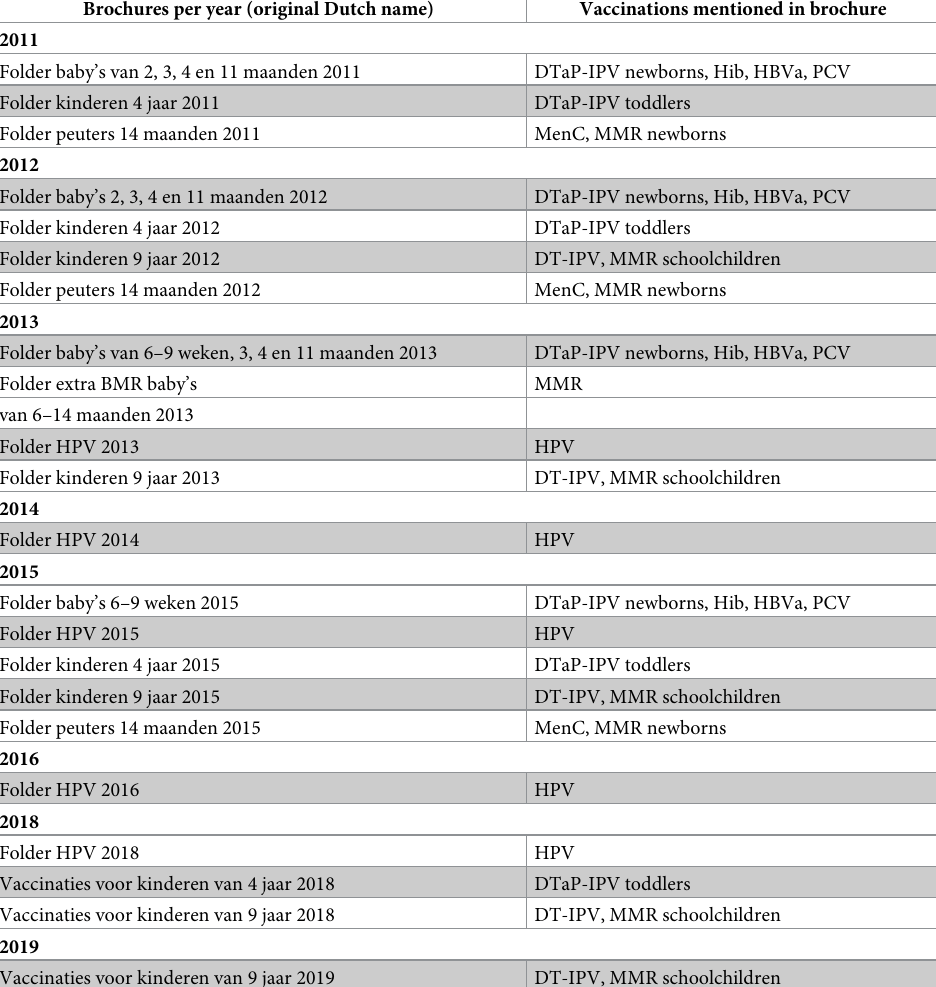
Table 2. Overview of the brochures per year and the vaccinations mentioned in each brochure. Brochures per year (original Dutch